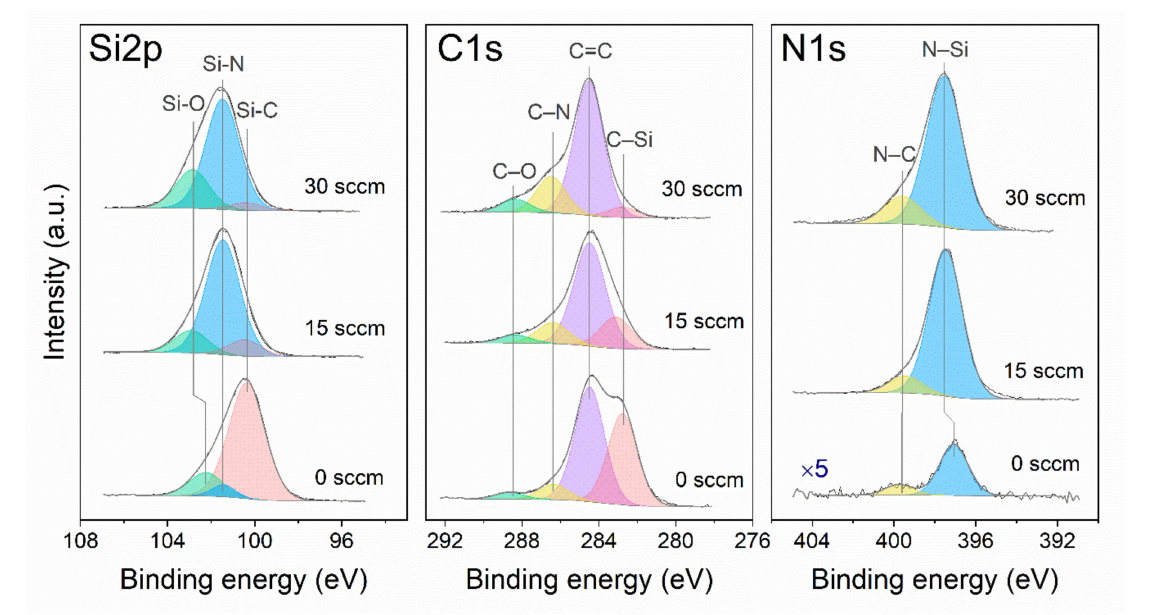
Figure 7. XPS spectra of SiC x N y films deposited at T dep = 300 ◦ C and different nitrogen flow